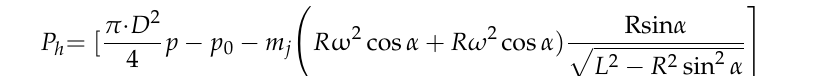
Figure 8. Temperature distribution of the piston skirt.